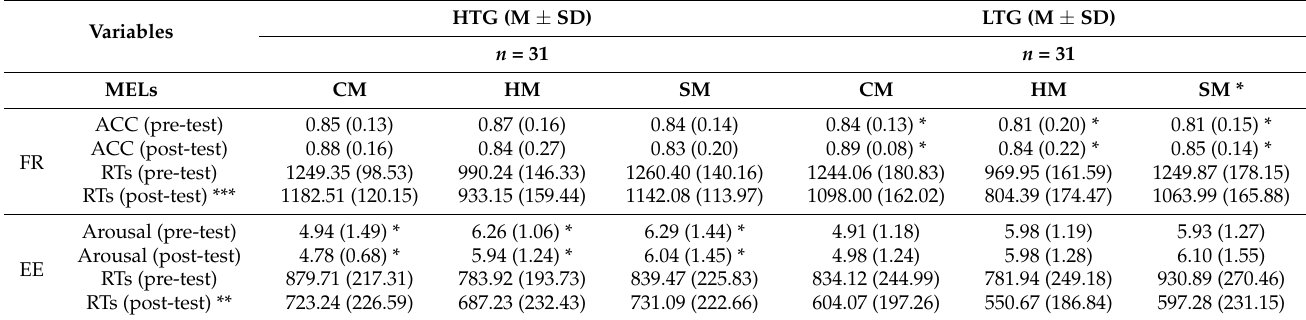
Table 2. Descriptive statistics of the facial recognition and emotional arousal task.